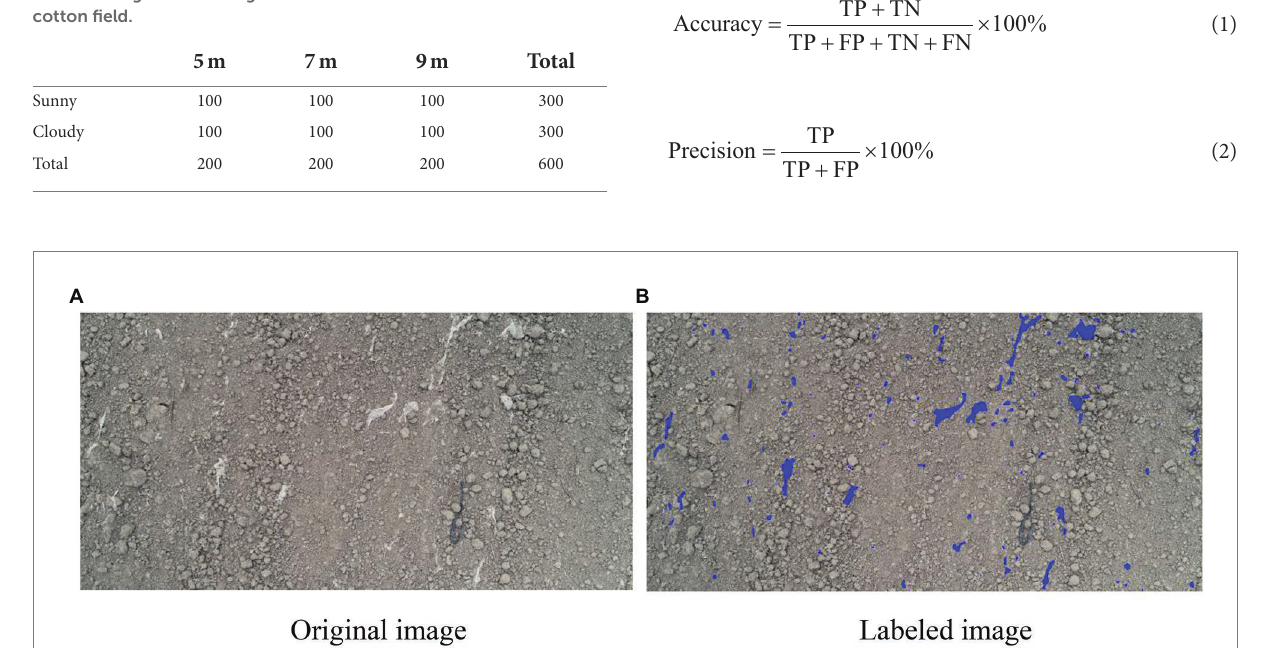
FIGURE 2 Image labelling: (A) Original image; (B) Labeled